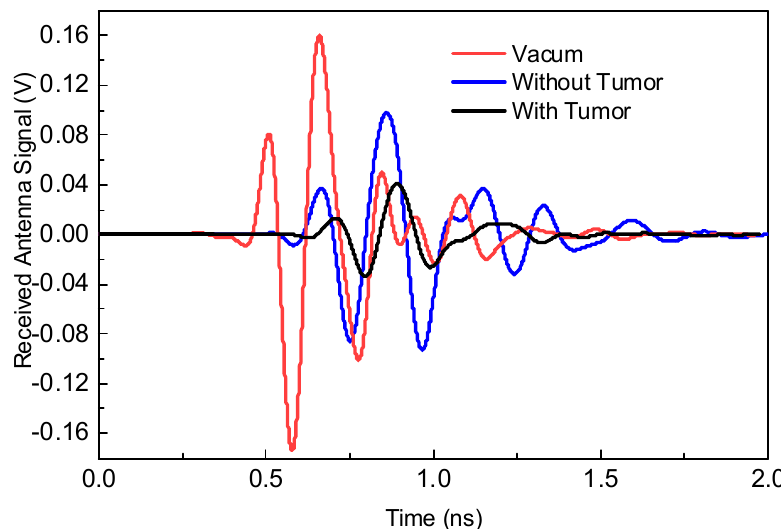
Figure 10. Received signal responses when both antenna sensors are positioned in contact with biological stacked organic layers.